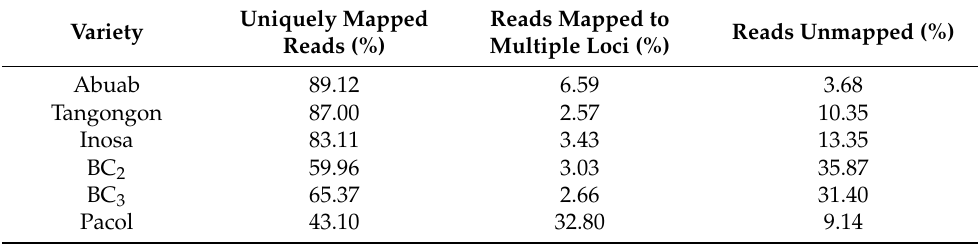
Table 4. Alignment rates of the reads generated from various Musa sp.